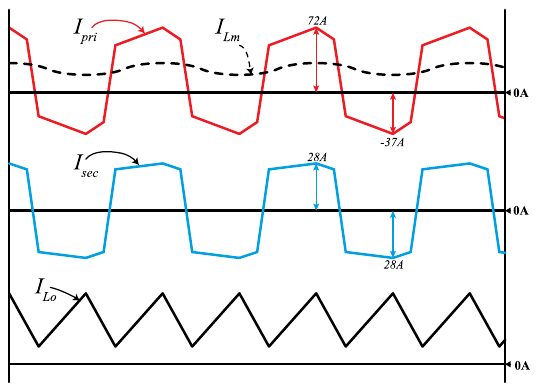
Figure 2. Magnetizing current imbalance by duty ratio fluctuation.